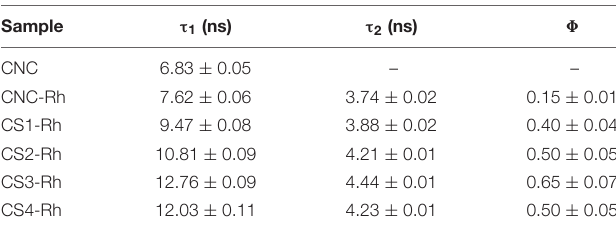
Absolute quantum yield values under excitation at 528 nm: emission monitored at 567 and 556 nm for CNC-Rh and Rh6G containing CNC/silica samples,